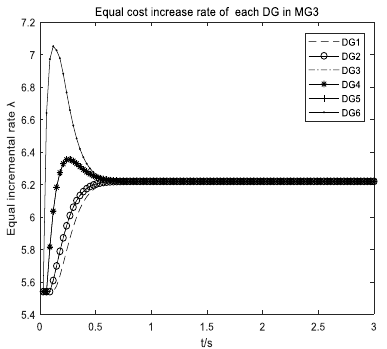
Figure 9. Equal cost increase rate of each DG.